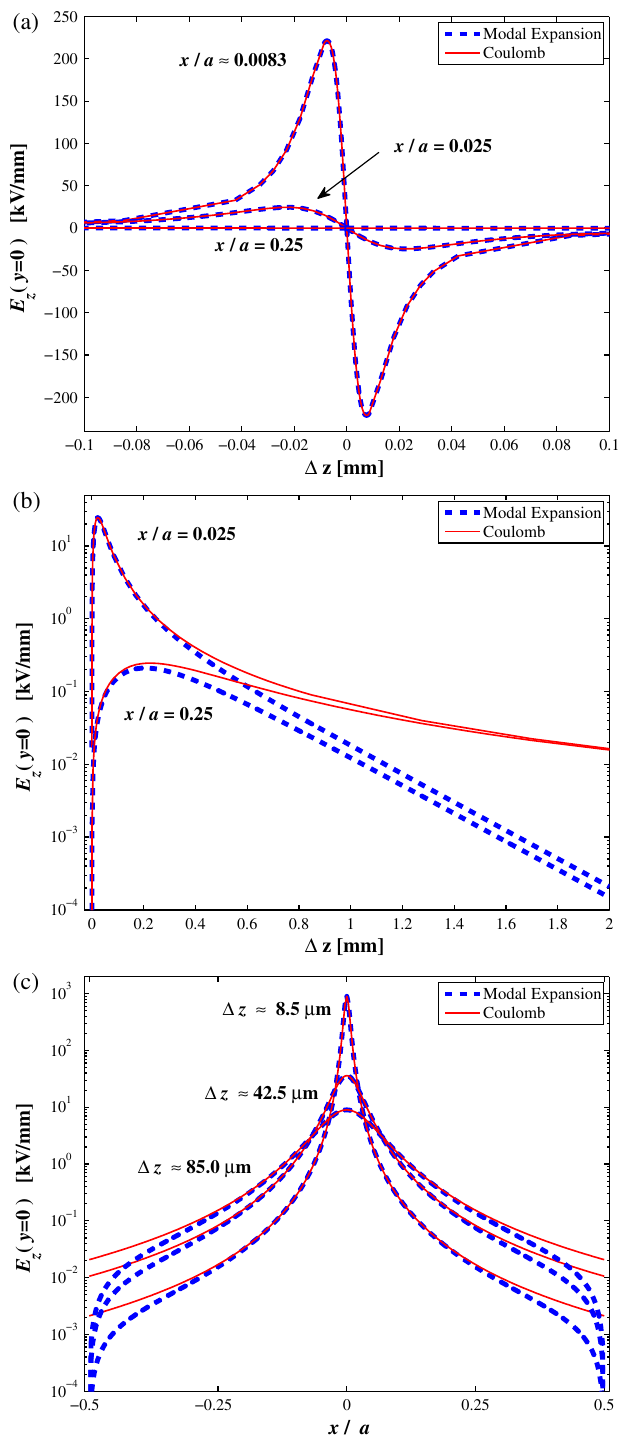
FIG. 7. (Color) Longitudinal electric field of a 1 nC charge, moving with a constant 5.5 MeV kinetic energy along a rectan- gular